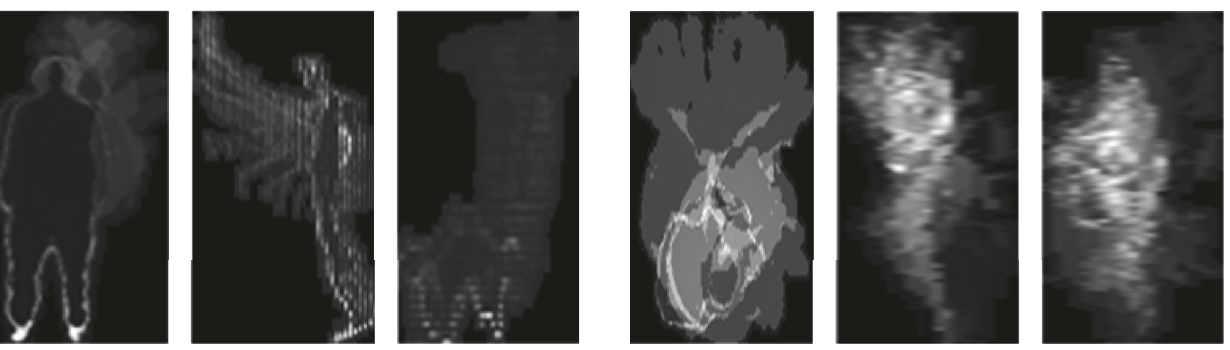
Figure 2: Three DMMs of a depth action sequence “ASL Z” from the front ( 𝑓 ) view, side ( 𝑠 ) view, and top ( 𝑡 ) view, respectively.